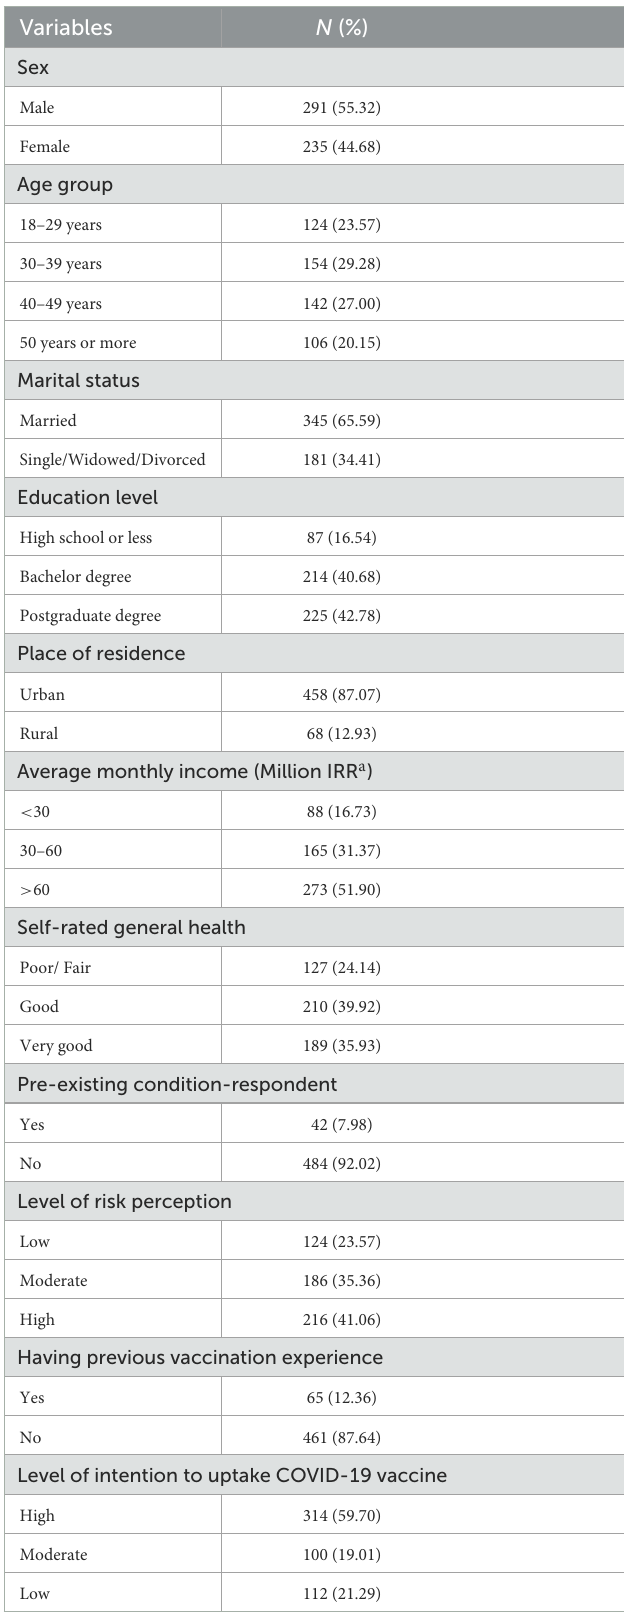
TABLE 1 Characteristics of the participants, cross-sectional survey, 2021.